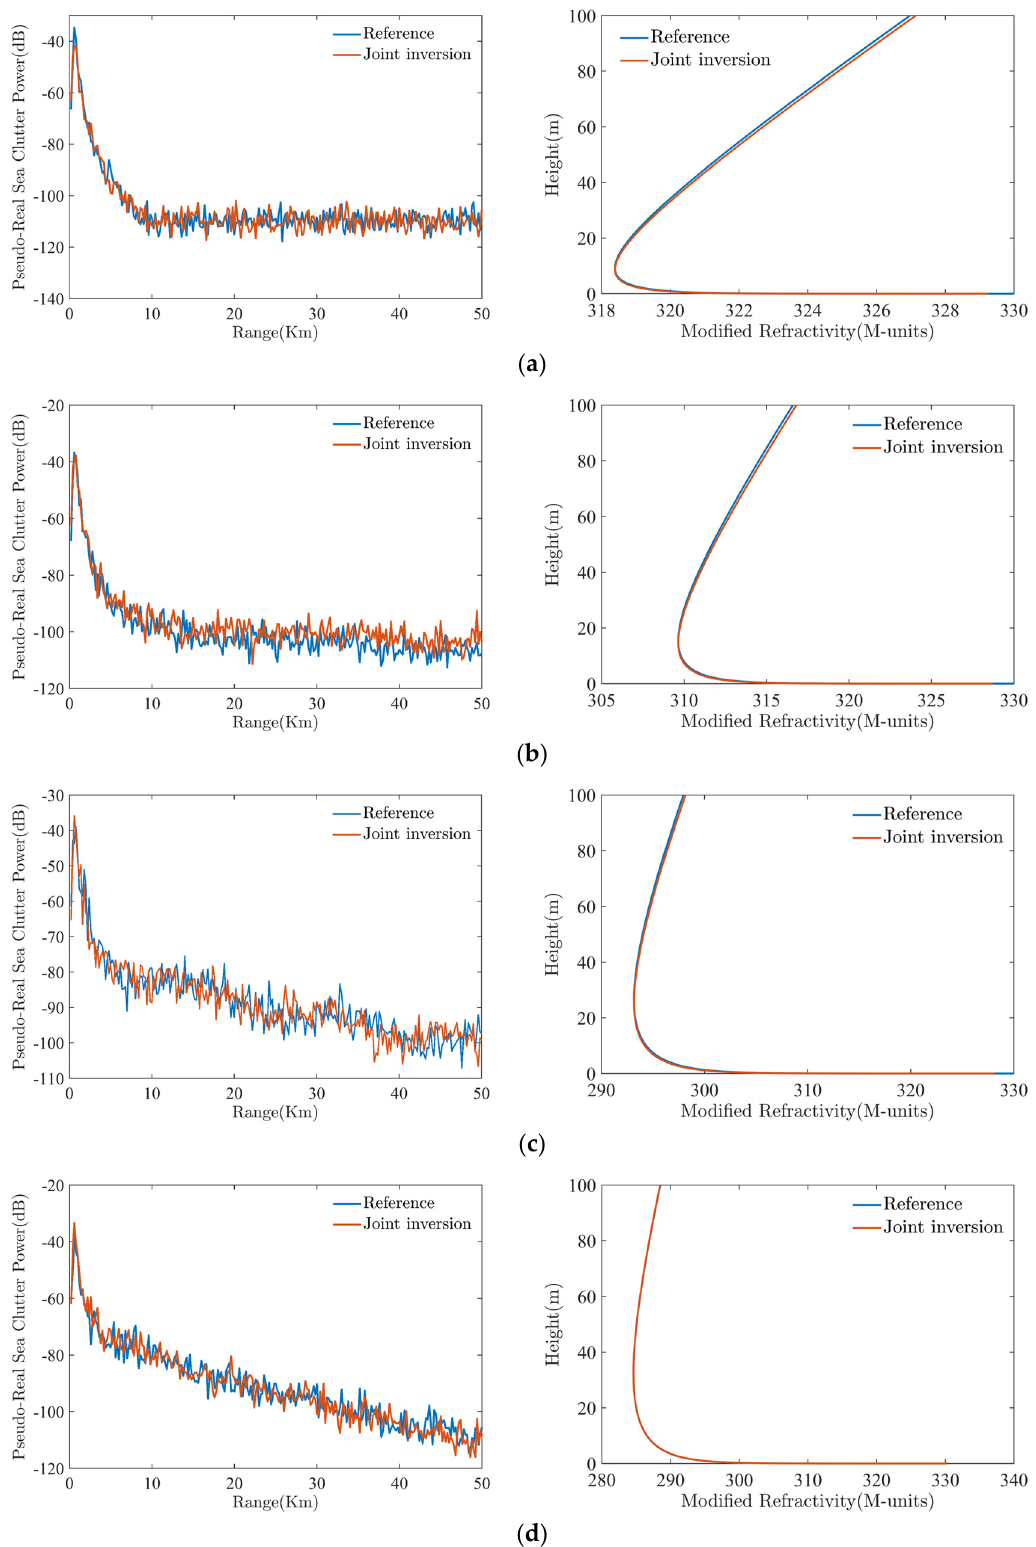
Figure 13. Comparison of refractivity profile and pseudo − real sea clutter power estimations results to reference EDHs: ( a ) d = 8.70 m; ( b ) d = 14.56 m; ( c ) d = 25.33 m; ( d ) d = 32.36 m.